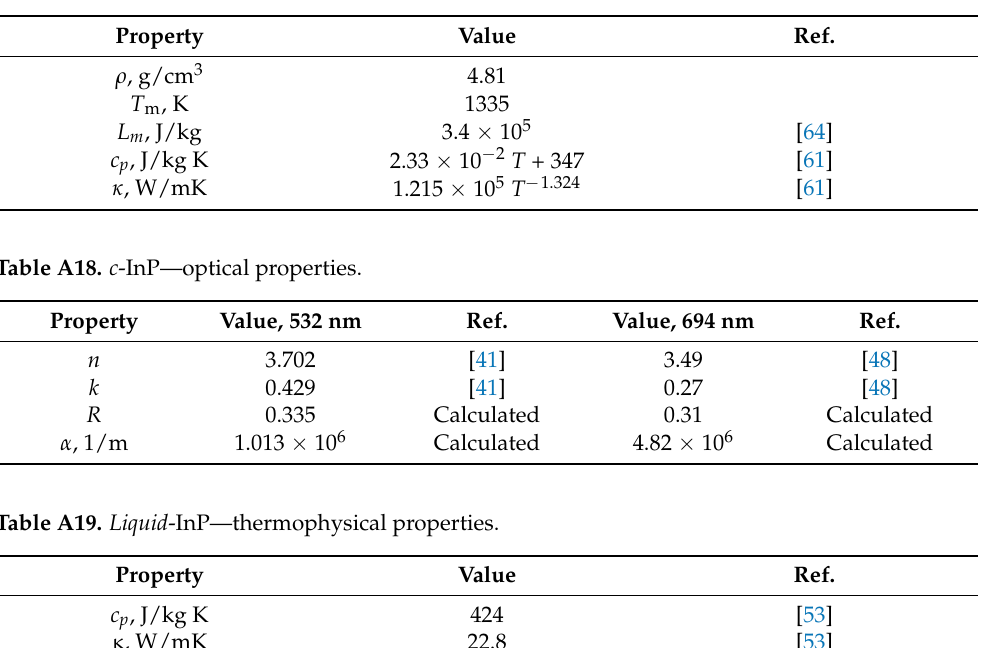
Table A17. c -InP—thermophysical properties.